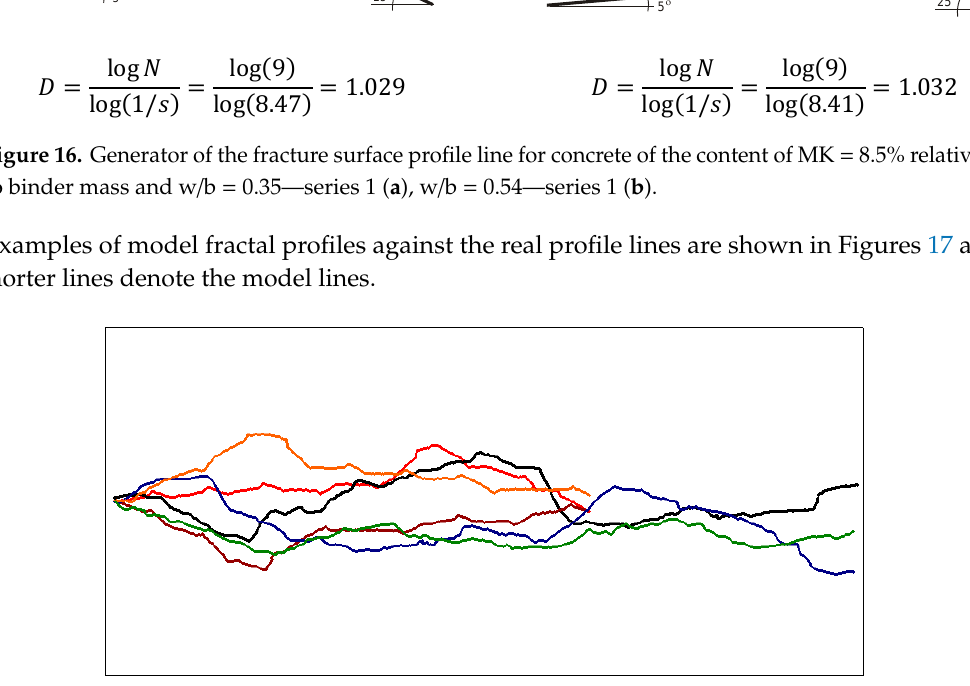
Figure 17. Examples of random profile lines based on the proposed generator vs. real profiles separated out of fracture surfaces of concrete series 1.